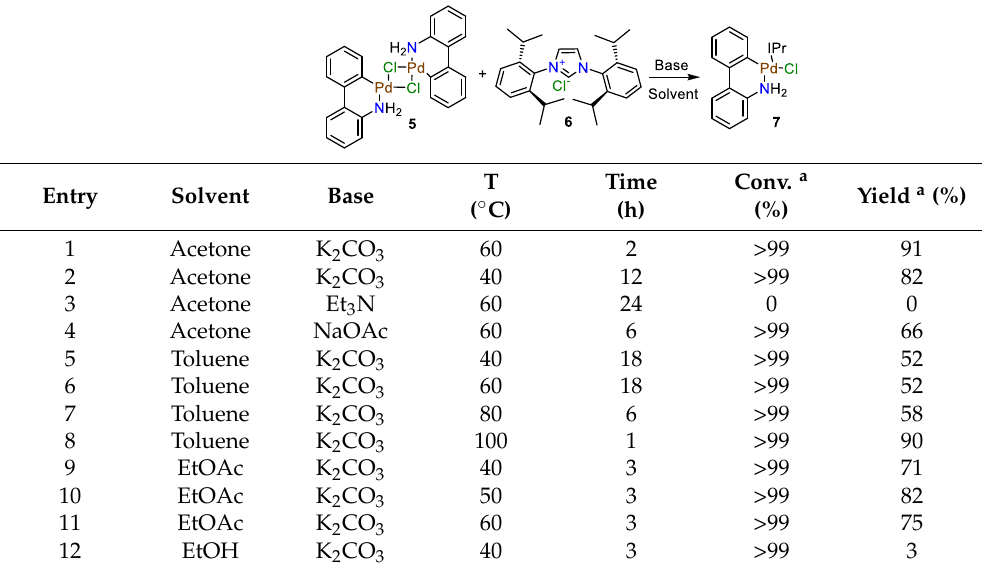
Table 1. Selected entries for the optimization of reaction conditions leading to palladacycle 7.